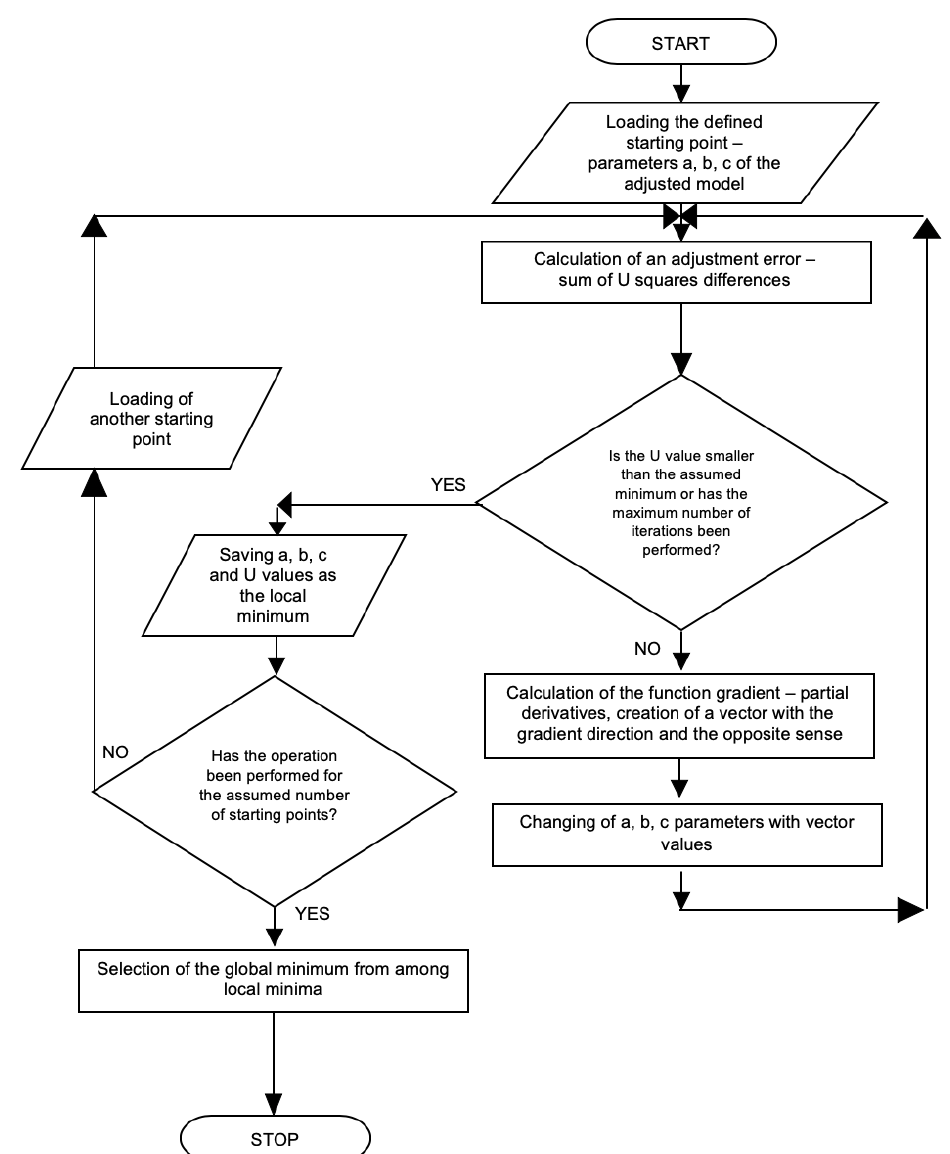
Figure 3. Flow chart determining the function minimum.